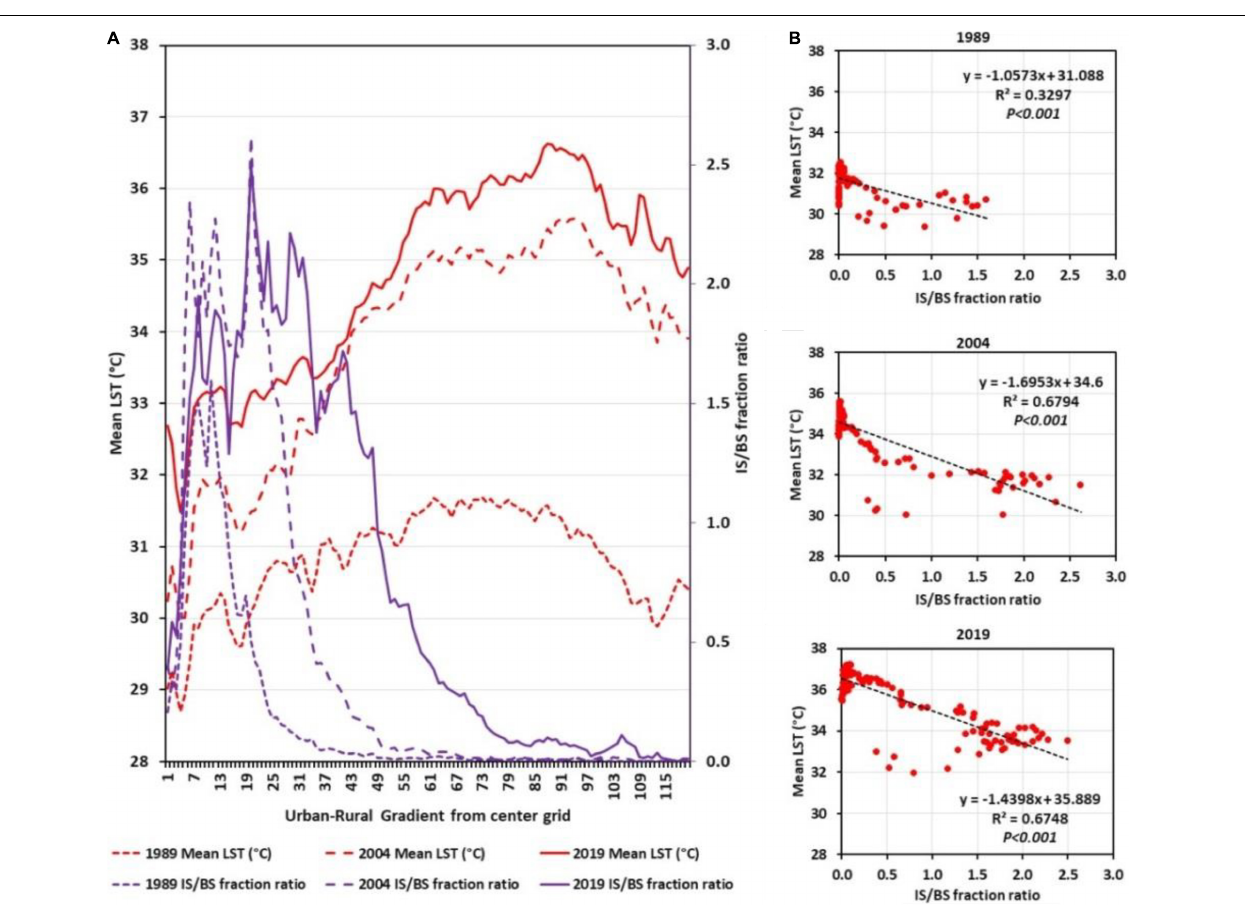
FIGURE 6 | (A) Spatial pattern of the MLST, ISBS–FR along the URG; and (B) scatter plots between MLST and the